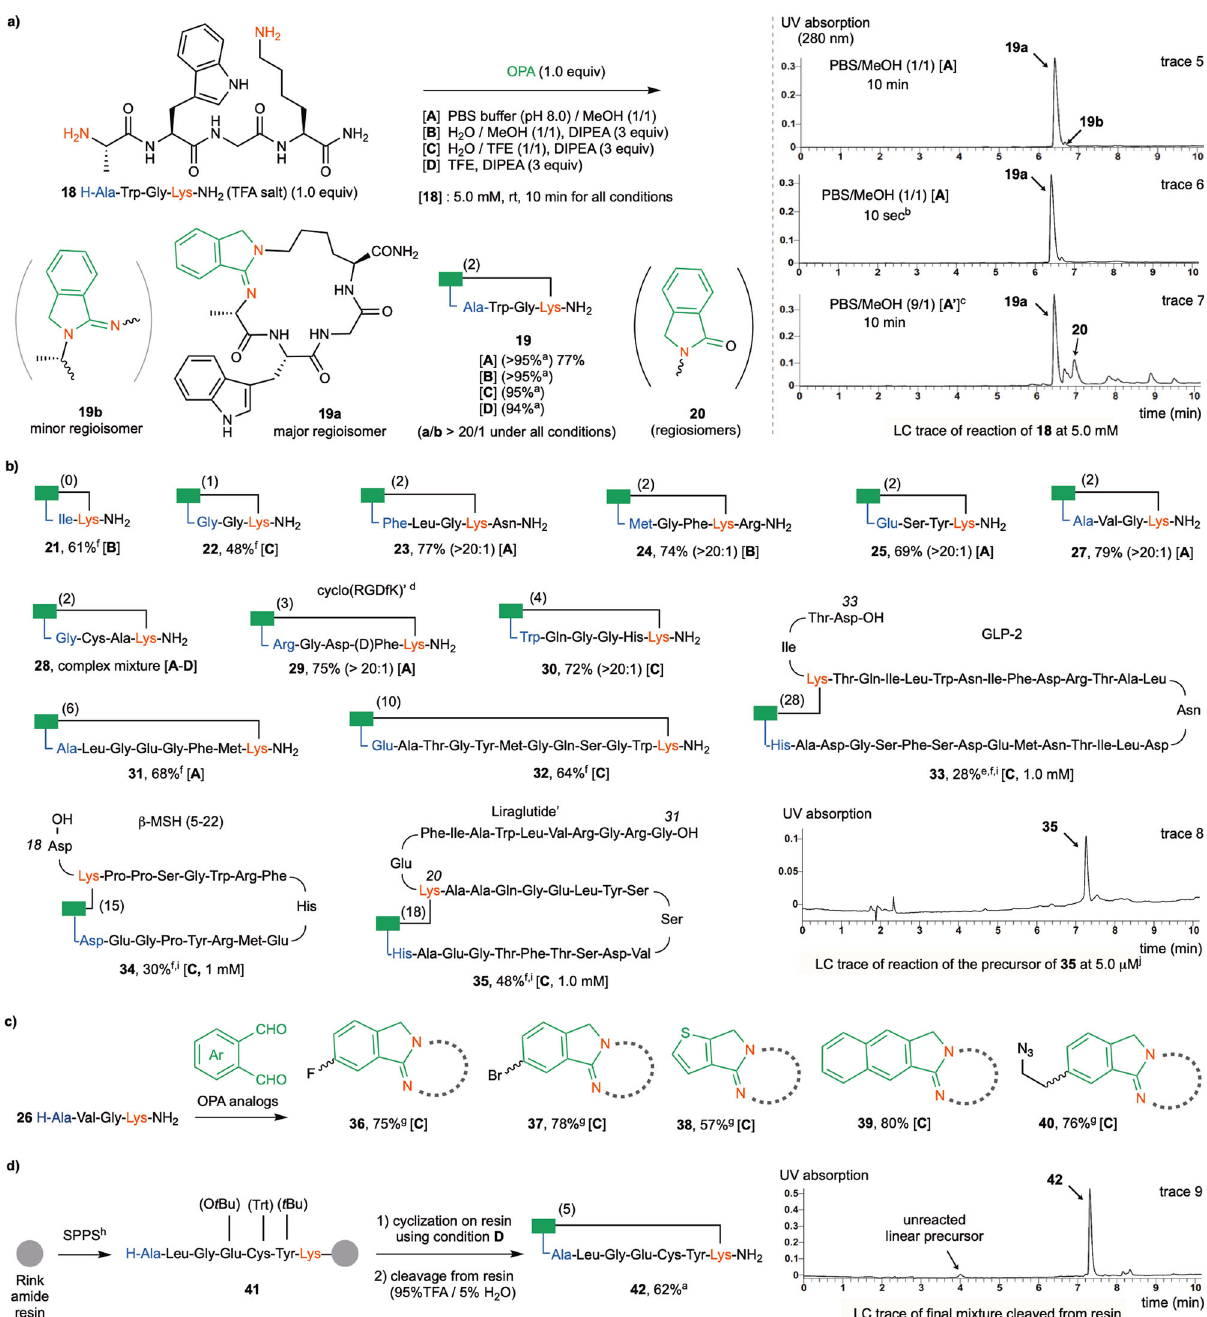
Fig. 3 OPA-2amines reaction for end-to-side stapling of unprotected peptides. a Reaction of model substrate 18 with OPA. b In fl uence of spacing units and amino acid composition. c Cyclization of H-Ala-Val-Gly-Lys-NH 2 26 with OPA analogs. d Cyclization on solid phase. Yield is based on the HPLC isolated product of reaction conducted at 5.0 mM concentration and 0.001-0.05 mmol scale unless otherwise speci fi ed. The number of spacing AA units is shown in parentheses next to the green rectangle symbol that represents the isoindolinimine motif. The ratio of two regioisomers is shown in parentheses next to product yield. a LC-estimated yield. b A small aliquot of the reaction mixture was taken and quenched with mixed solvents of H 2 O/MeOH/HCO 2 H before subjection to LC-MS analysis. c Condition A ’ is same as A except the ratio of buffer and MeOH. d Cyclo(RGDfK) is a cyclic pentapeptide joined by fi ve backbone amide bonds. e The acyclic isoindolinone side product was formed in about 40% LC yield. f The ratio of regioisomers was dif fi cult to determine by LC. g The product was obtained as a mixture of regioisomers. h See Supplementary Figs 29 and 30 for details of SPPS on resin. i Reaction was conducted at 1.0 mM for 10 min. j Reaction was conducted at 5.0 μ M for 10 min. Thr(ol): L-threoninol. The uncapped N-terminal AA units are marked in ocean blue, the lysine units and amino groups are marked in red, the OPA reagent and isoindolinimine core are marked in green.